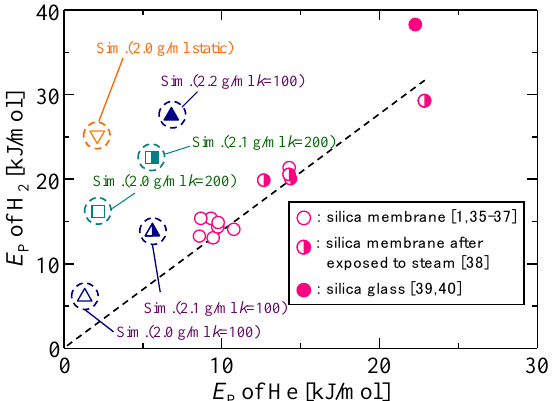
Figure 5. Correlation between the activation energy of helium and that of hydrogen.